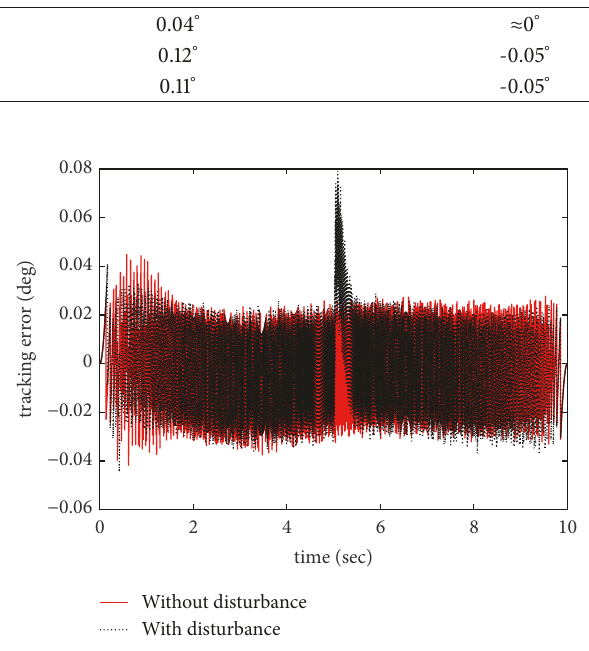
Figure 8: Two tracking error curves of second-order LADRC.